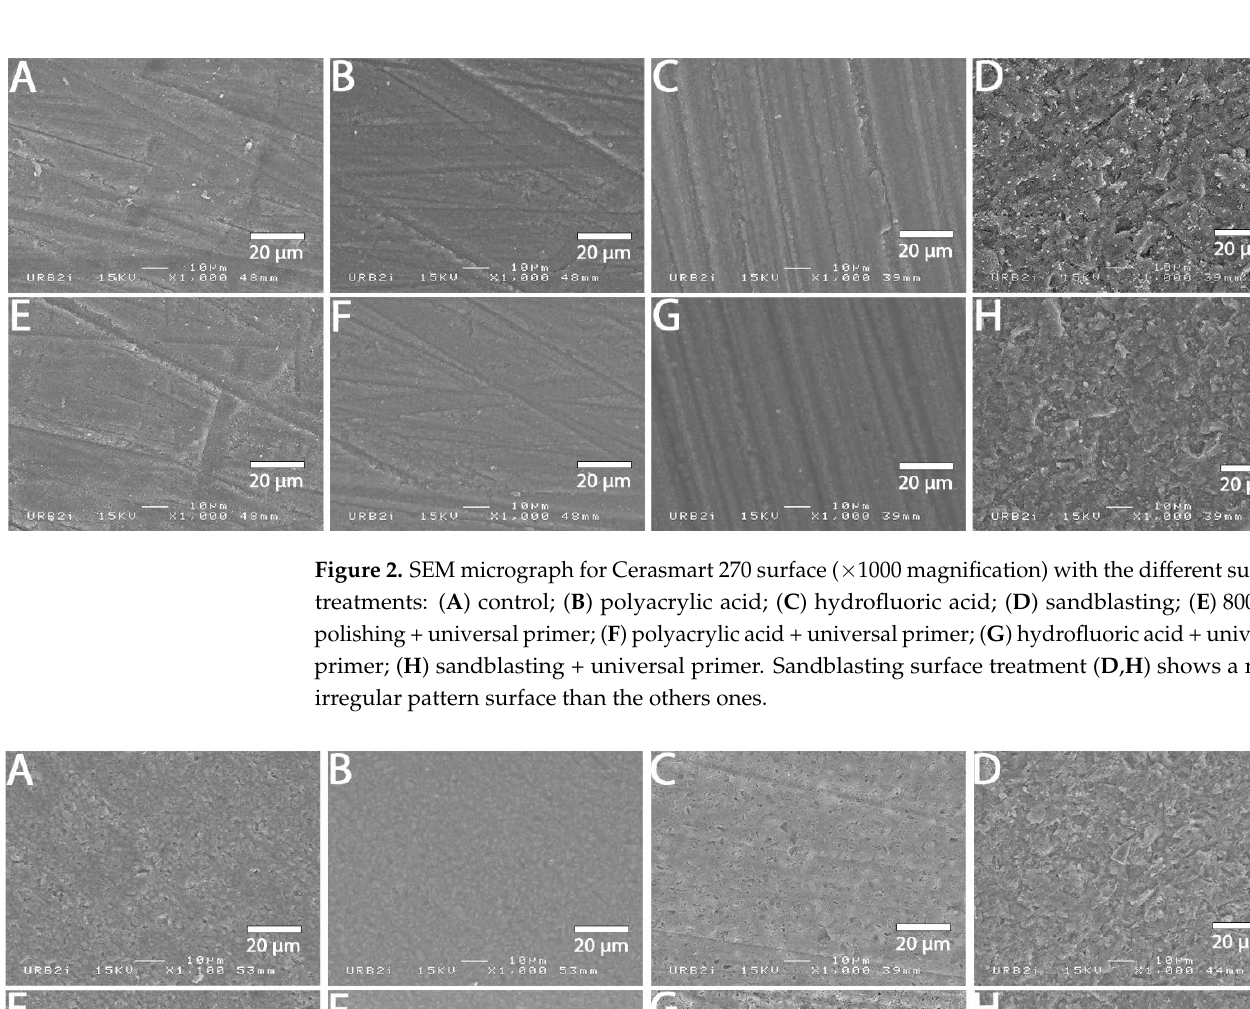
Figure 1. SEM micrograph for Brillant Crios surface (×1000 magnification) with the different surface treatments: ( A ) control; ( B ) polyacrylic acid; ( C ) hydrofluoric acid; ( D ) sandblasting; ( E ) 800 grit polishing + universal primer; ( F ) polyacrylic acid + universal primer; ( G ) hydrofluoric acid + uni- versal primer; ( H ) sandblasting + universal primer. Sandblasting surface treatment ( D , H ) shows a more irregular pattern surface than the other ones.